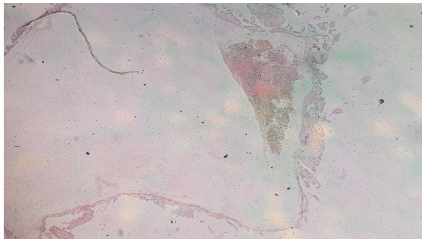
Figure 5: Hydropic villus in complete hydatidiform mole. A histo- logic section of hydropic villus in a 36-year-old woman presenting withvaginalbleedingandpassageofgrape-likevesiclespervaginam.